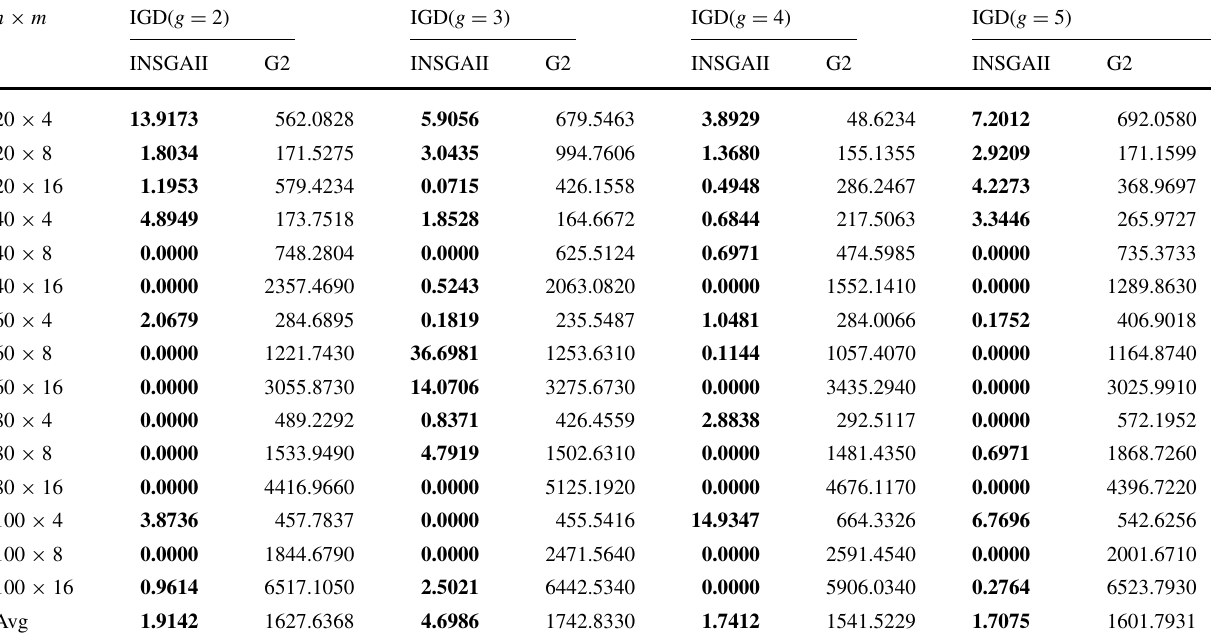
Table 7 Comparisons of the IGD values between INSGAII and G2 n ×